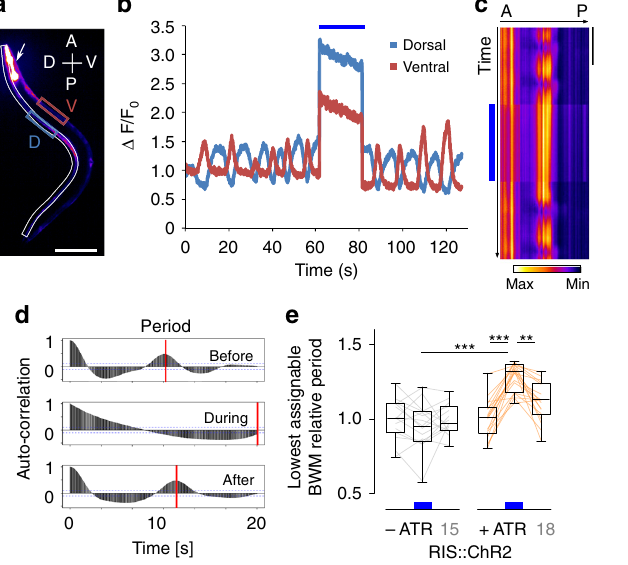
Fig. 2 RIS photoactivation stopped muscular Ca 2 + -dynamics. a Maximum intensity projection of RCaMP imaging in BWM cells of an immobilized animal (arrow: pharynx, p myo-2 ::mCherry marker). Boxed regions: Violet, blue: regions of interest for dorso-ventrally alternating activity; white: region of interest for kymographic analysis of dorsal muscle Ca 2 + signals along the body in c , scale bar = 100 µ m, A, P, V, D: anterior, posterior, ventral, dorsal, respectively. b Ca 2 + dynamics in both regions of interest from a (V = ventral, D = dorsal muscle cells) measured before, during, and after RIS::ChR2 photostimulation, denoted by the blue bar. F 0 de fi ned as the mean RCaMP intensity during the fi rst 4.5 s of the recording. c Kymograph representation of the Ca 2 + dynamics along the dorsal side. The RCaMP signal was normalized for visualization purposes. RIS photoactivation: blue bar. Scale bar = 10 s. d Example of the RCaMP signal autocorrelation for a speci fi c point in the BWM over time, before, during, and following illumination. Ventral and dorsal BWMs were analyzed. Red lines: Peak autocorrelation of two consecutive Ca 2 + waves and their time lag (if no consecutive Ca 2 + signals were detected during the stimulation period, stimulus duration was taken as lower bound). e Distribution of the mean change in the muscular Ca 2 + oscillation period per animal, compared to before RIS photoactivation. When no oscillations occurred, the duration of photostimulation (20 s) was assumed as minimal period. Compared are animals without and with ATR, number of animals indicated in gray numbers. *** p ≤ 0.001; ** p ≤ 0.01; statistical signi fi cance tested by ANOVA, Bartlett ’ s test, and Bonferroni ’ s multiple comparison